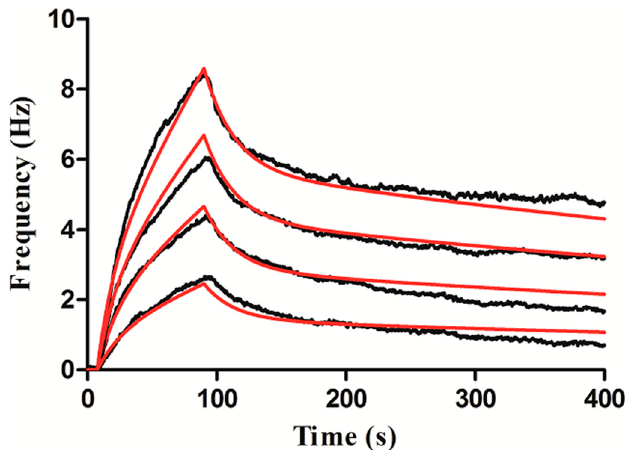
Figure 10. Kinetic evaluation of the interaction between fucose and UEA-I.